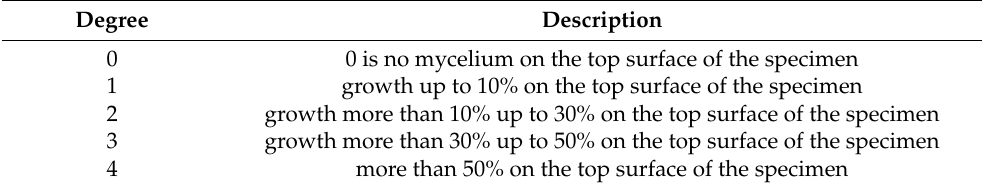
Table 6. Surface resistance to mold growth: degree and evaluation.